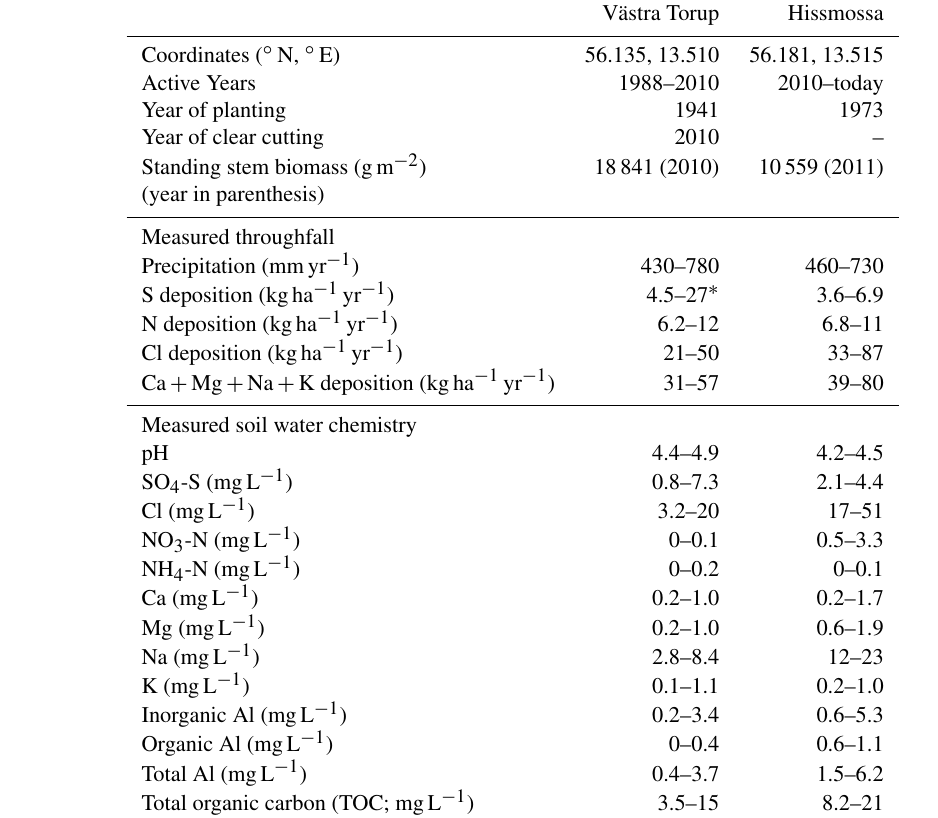
Table 1. Characteristics of the two